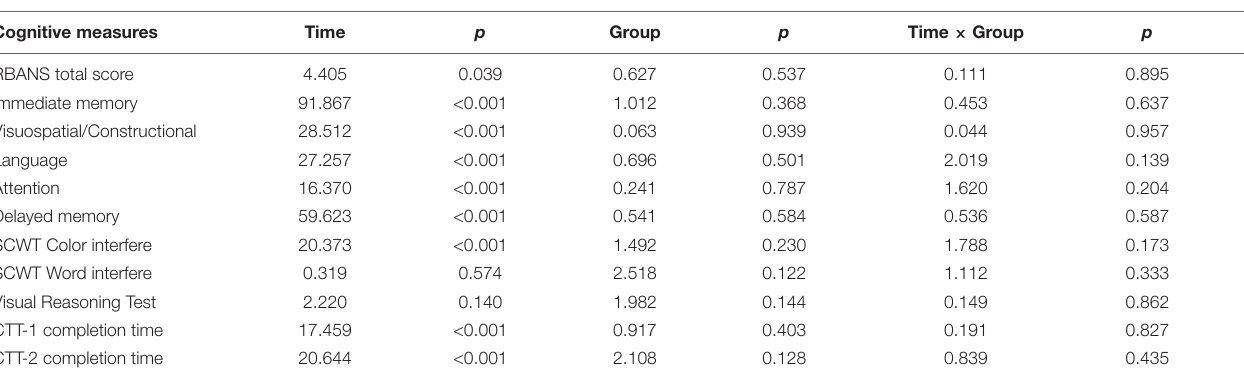
TABLE 2 | Cognitive performance at 1 year after the interventions. Cognitive measures